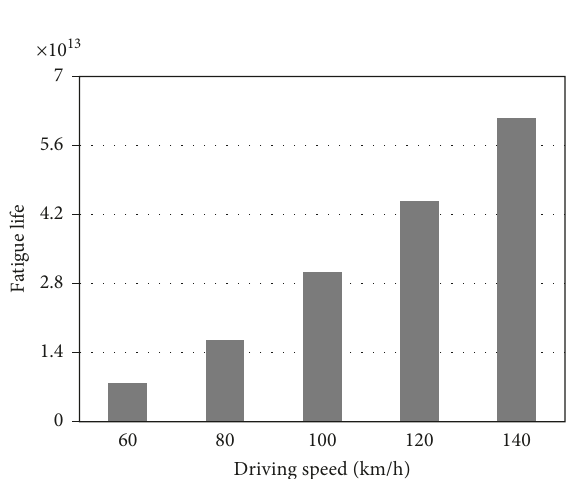
Figure 16: The fatigue life of the asphalt pavement subjected to different driving speeds after loading cycles of 1 × 10 6